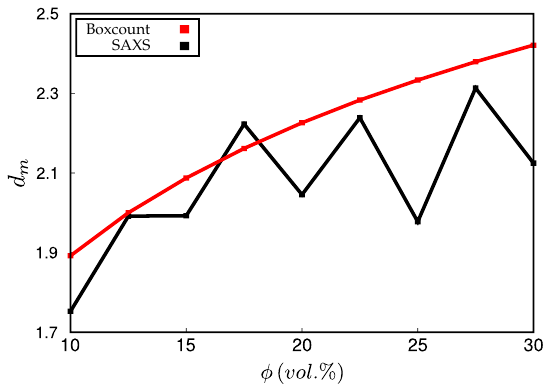
Figure 8. Mass fractal dimension, d m , vs. filler volume fraction, φ . Black: d m calculated from fits to the scattering intensity in the range 5 × 10 − 4 < q < 4 × 10 − 3 ; red: d m calculated via box-counting algorithm. Note that the system studied here for φ = 20% is identical to the systems in Figures 4 and 7.